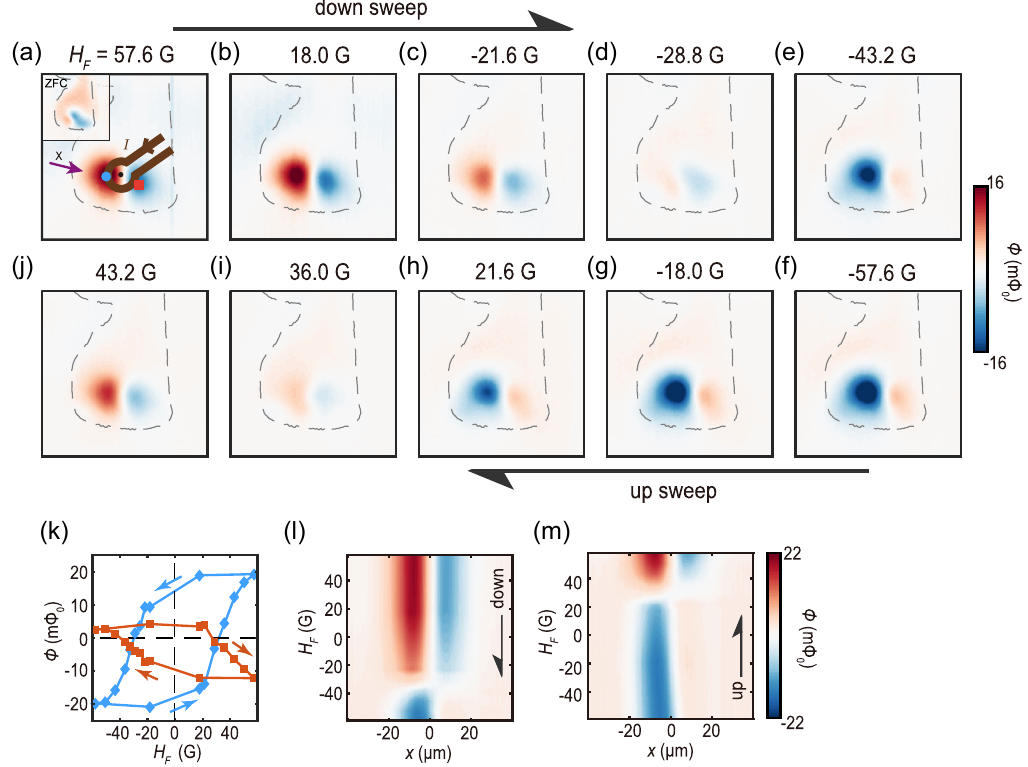
FIG. 3. Hysteretic switching of QAV and its antivortex using a local field. (a) – (j) Magnetometry images of an Fe(Se,Te) sample obtained at 1.5 K and zero field. The dashed lines outline the shape of the sample as obtained from susceptometry. A local field H F was applied by passing a dc current through the field coil [(a), brown line] on the nano-SQUID probe at the middle of the vortex-antivortex dual [(a), black dot] and then removed before each image was taken. The history of the images is indicated by the black arrows showing field sweeping directions. (a) Inset: image after zero-field cooling (ZFC) and before applying any H F . (k) Flux signals extracted from the two points [(a), blue dot and orange square] as a function of H F . The magnetic hysteresis loops exhibiting opposite winding with H F correspond to QAVand antivortex, respectively. (l),(m) Interpolated images from the line cuts through the pattern in (a) (arrow direction) as a function of H F from down and up sweeps, respectively. The hysteresis in the switching was reminiscent of a ferromagnetic magnetization loop and suggested spontaneously broken time-reversal